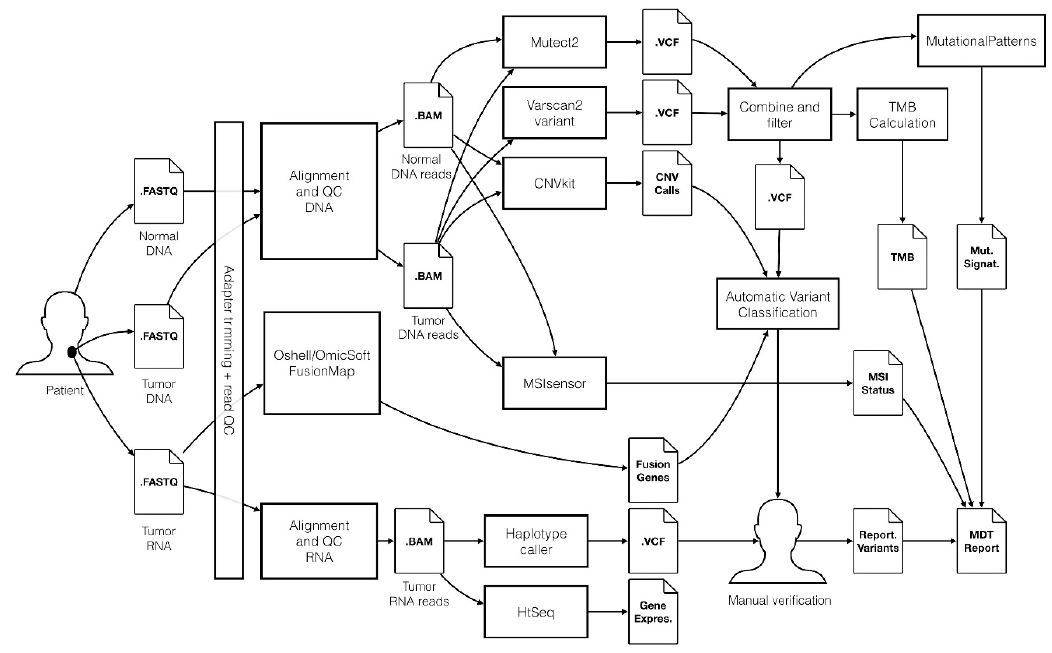
Figure 7. Overview of the bioinformatics workflow for processing of WES and RNA sequencing data